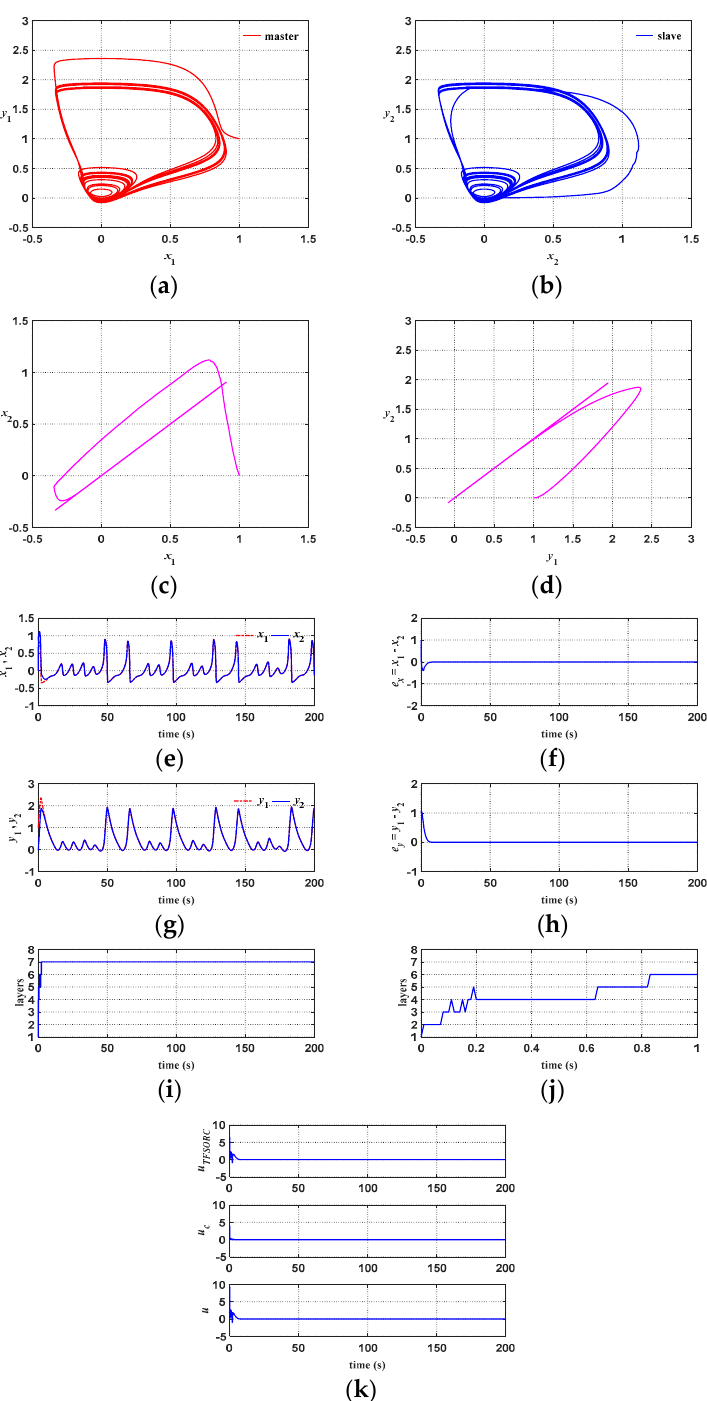
Figure 13. Simulation results of ATFSORC chaotic system synchronization control ( g = 1): ( a ) Master system phase diagram for ATFSORC; ( b ) Slave system phase diagram for ATFSORC; ( c ) x 1 , x 2 phase diagram for ATFSORC; ( d ) y 1 , y 2 phase diagram for ATFSORC; ( e ) x 1 , x 2 response for ATFSORC; ( f ) Error e x for ATFSORC; ( g ) y 1 , y 2 response for ATFSORC; ( h ) Error e y for ATFSORC; ( i ) Number of association memory layers for ATFSORC; ( j ) Number of association memory layers for ATFSORC (partial); ( k ) Control amount for ATFSORC.